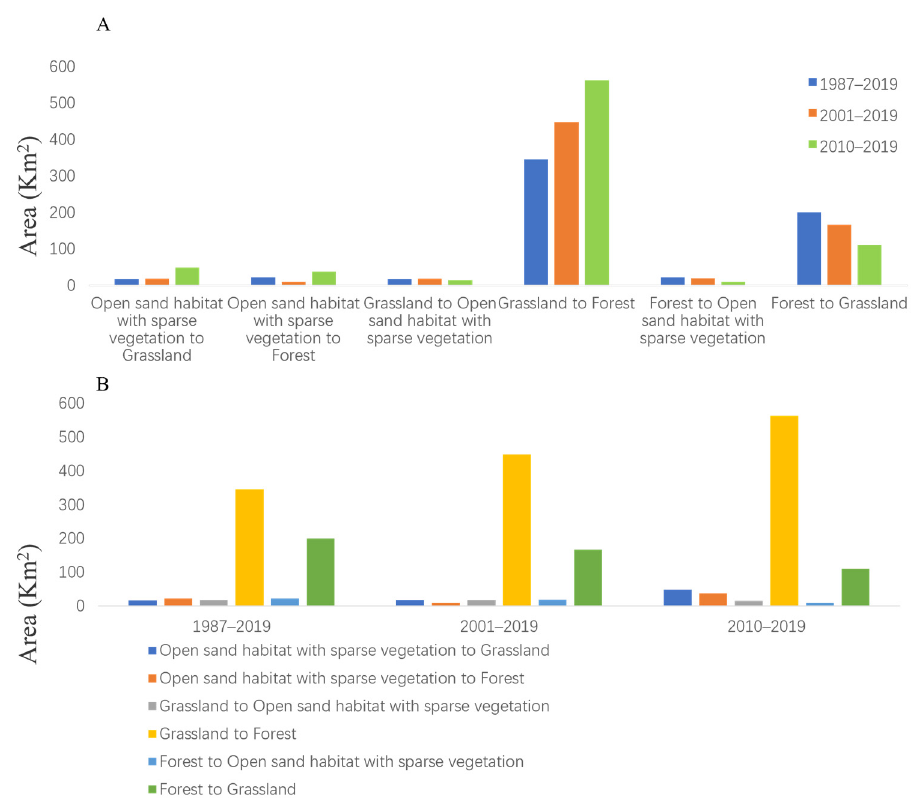
Figure 7. Comparison of vegetation changes within different periods (( A ) the changes of the three categories in three different time periods; ( B ) the changes of the 6 conversion categories in the same time.).